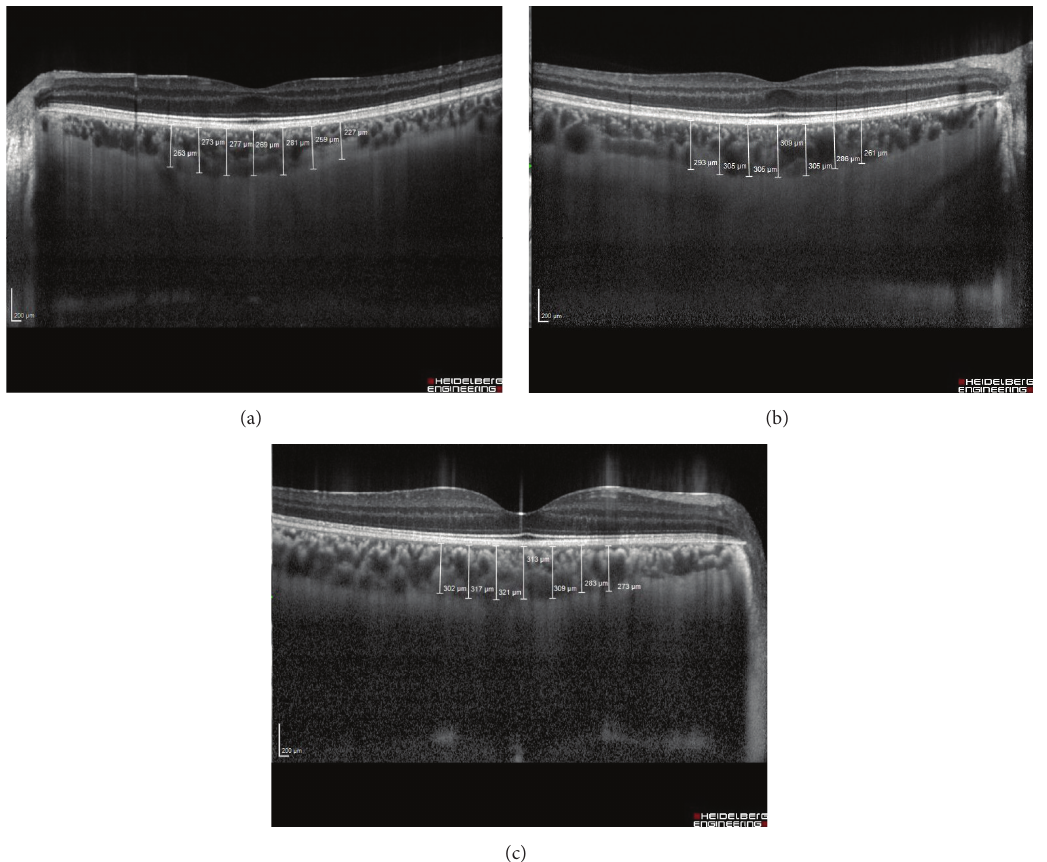
Figure 1: Representative EDI-OCT images of the choroid of a patient with FUS and a healthy control subject. (a) Choroidal thickness of the affected eye in a patient with FUS. (b) Choroidal thickness of the unaffected eye of the same patient with FUS. (c) Choroidal thickness of the eye in a healthy control subject.